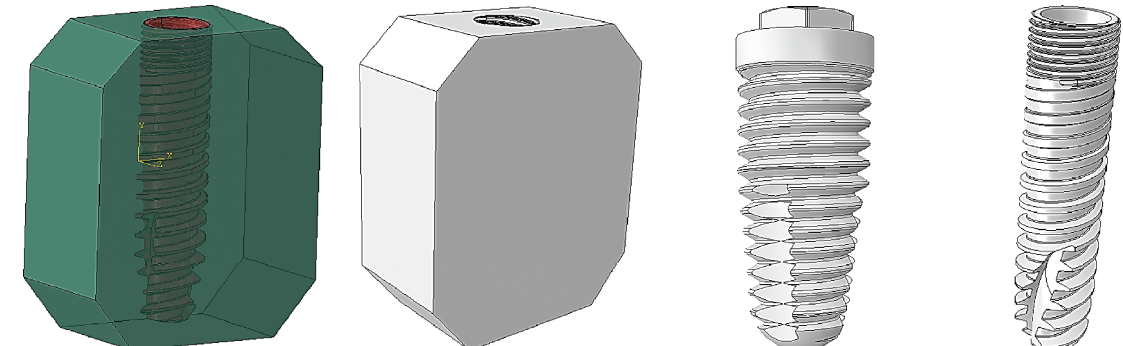
Figure 2: Screw M12, Astra Tech, and bone in software and assembly of both models in simulation.